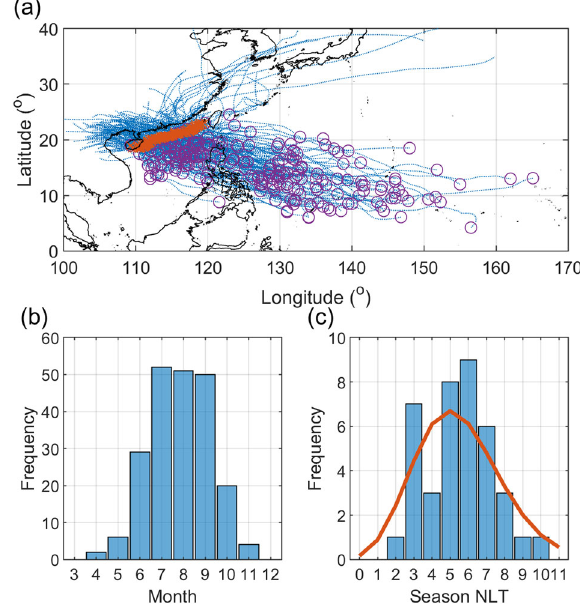
Fig. 6 Climatology of TCs making landfall in South China between 1981 – 2017. Tracks of typhoons making landfall in South China (blue lines) in the CMA best track database are shown in a with genesis locations (mauve circles) and landfall locations (orange crosses). A distribution of South China landfall event month is shown in b . The distribution of seasonal number of landfalling typhoons (NLT) in South China is shown in c with a Poisson distribution of the same mean (5.32) overlaid for